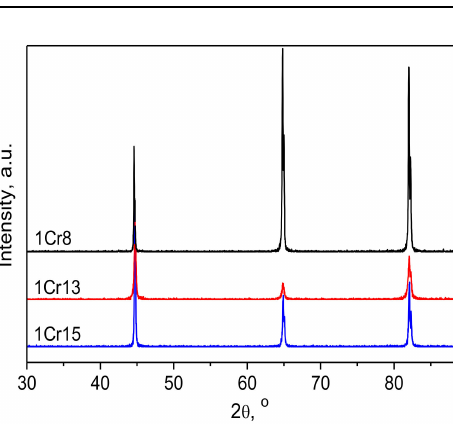
Figure 1. XRD patterns for Cr